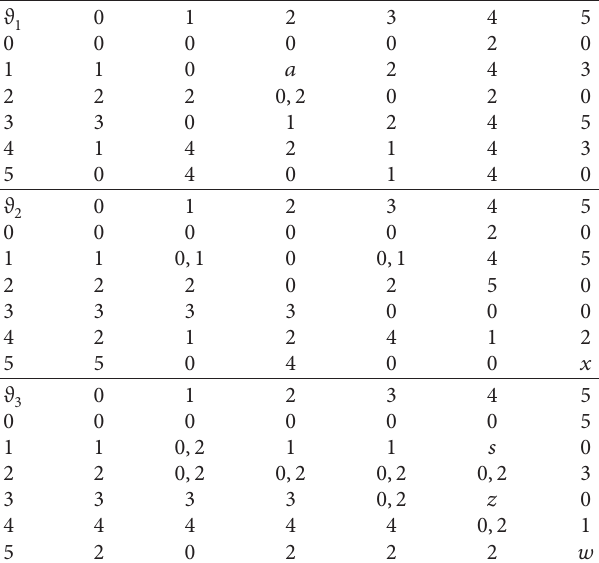
Table 3: Neutro hyper